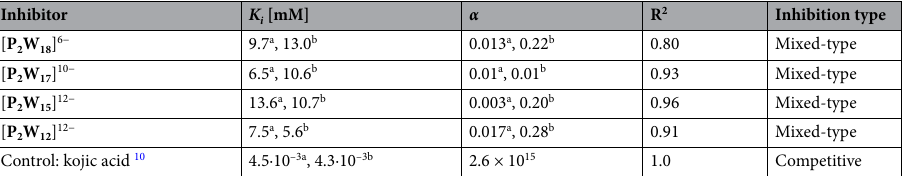
Table 1. Summary of kinetic evaluation of Ab PPO4 inhibition by Wells–Dawson POTs. K i : inhibition constant. α : inhibition parameter, R 2 : curve fit determination coefficient; the parameters were determined a from activity plot and b from the Lineweaver–Burk slopes or intercepts. For comparison, the results for the Keggin series are provided in 27 .